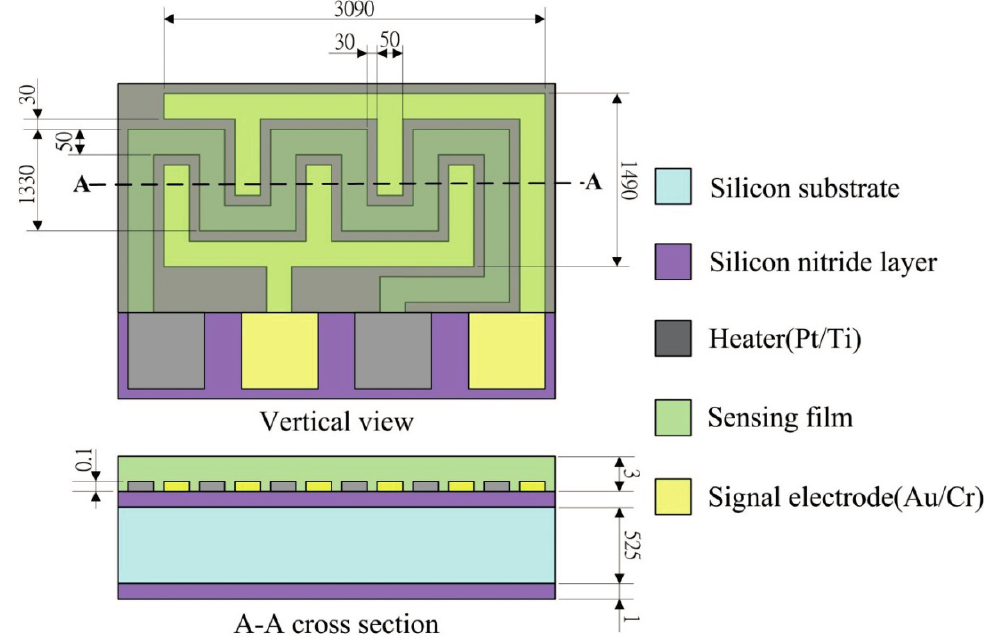
Figure 2. Schematic diagram of the ZnO gas sensor (unit: μ